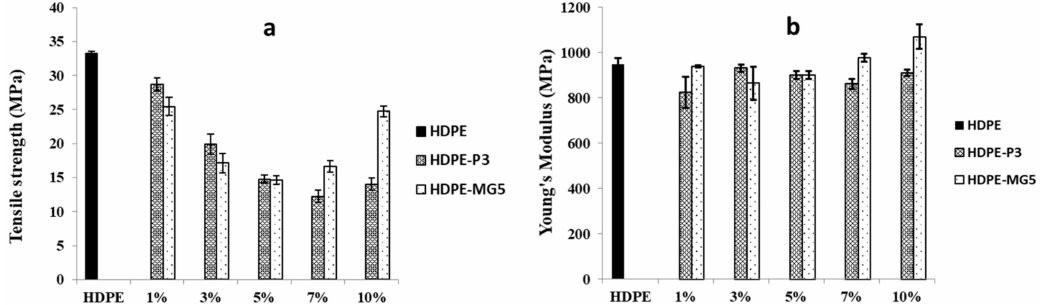
Figure 6. Mechanical properties of HDPE-P3 and HDPE-MG5 composites ( a ) tensile strength; ( b ) Young’s